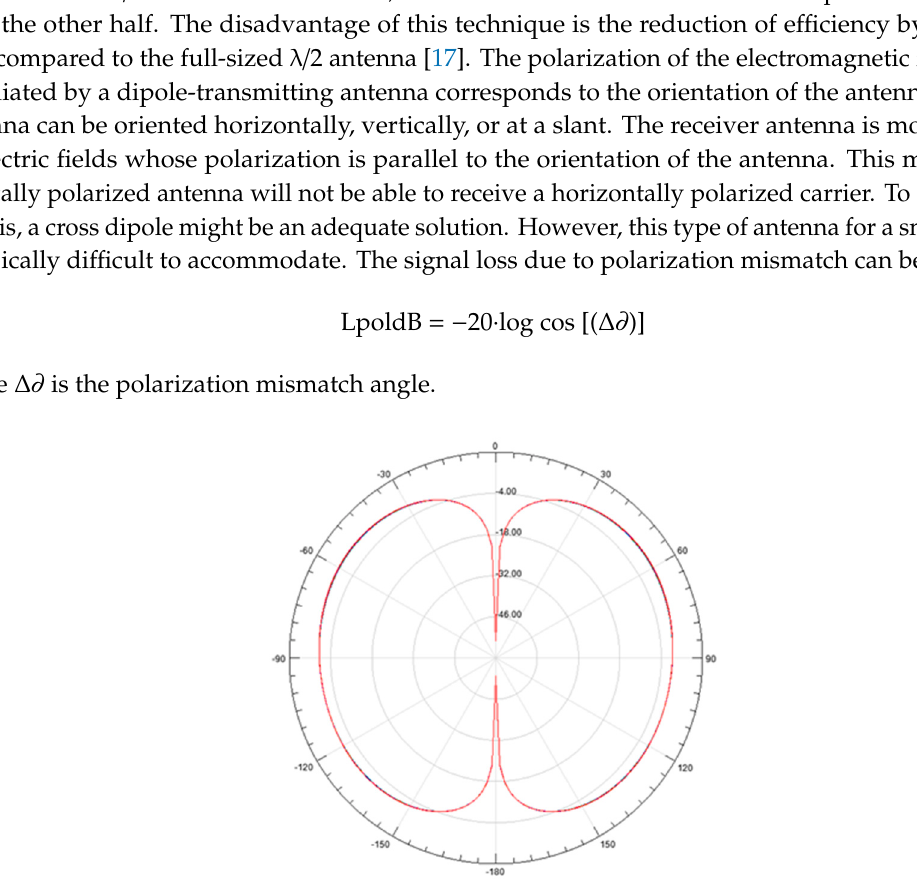
Figure 3. The typical field pattern of a monopole λ /4 antenna.